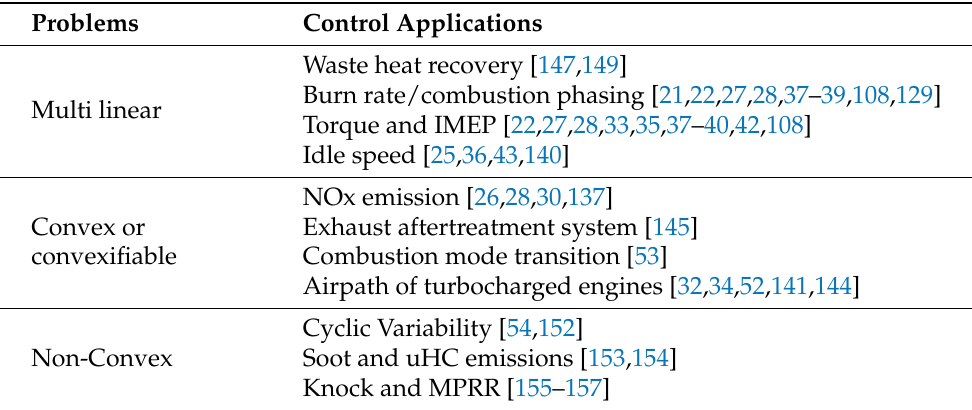
Table 2. Classification of ICE control problems based on the engine model and optimization